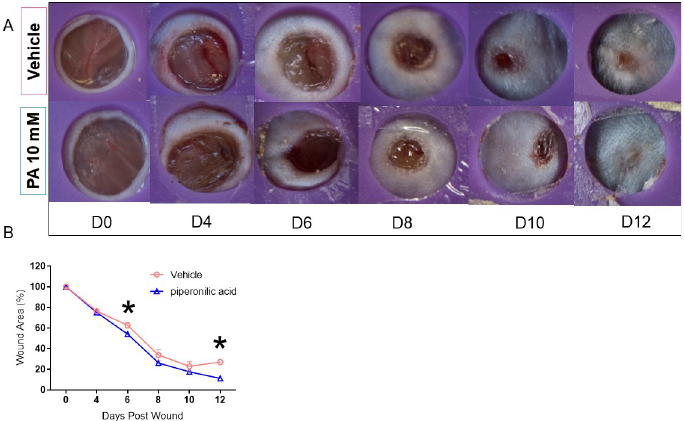
Fig 2. The macroscopic aspects of the PA 10mM vs. vehicle treated wounds until day 12. Wounds were photographed (A) (representative of five distinct experiments). Wounds were treated with 10mM PA vs. vehicle were measured from day 0 to day 9 (B) n = 5 � p <